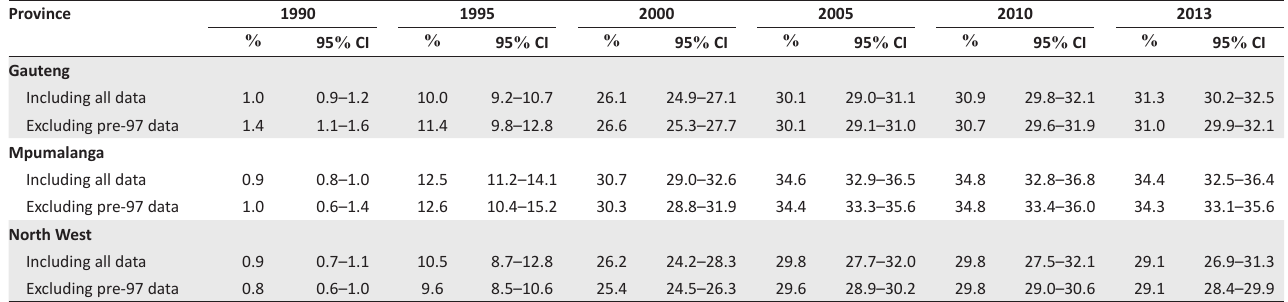
TABLE 3: Model estimates of antenatal HIV prevalence (public